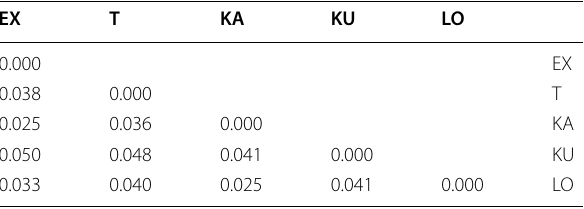
Φ PhiPT value Table 8 Pairwise population matrix of Nei’s genetic distance of the giant plantain populations based on 8 ISSR markers